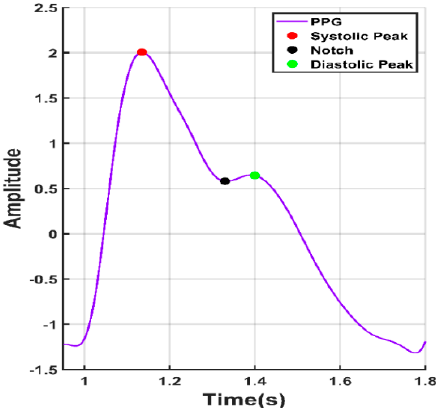
Figure 1. A typical photoplethysmograph (PPG) waveform with notch, systolic peak, and diastolic